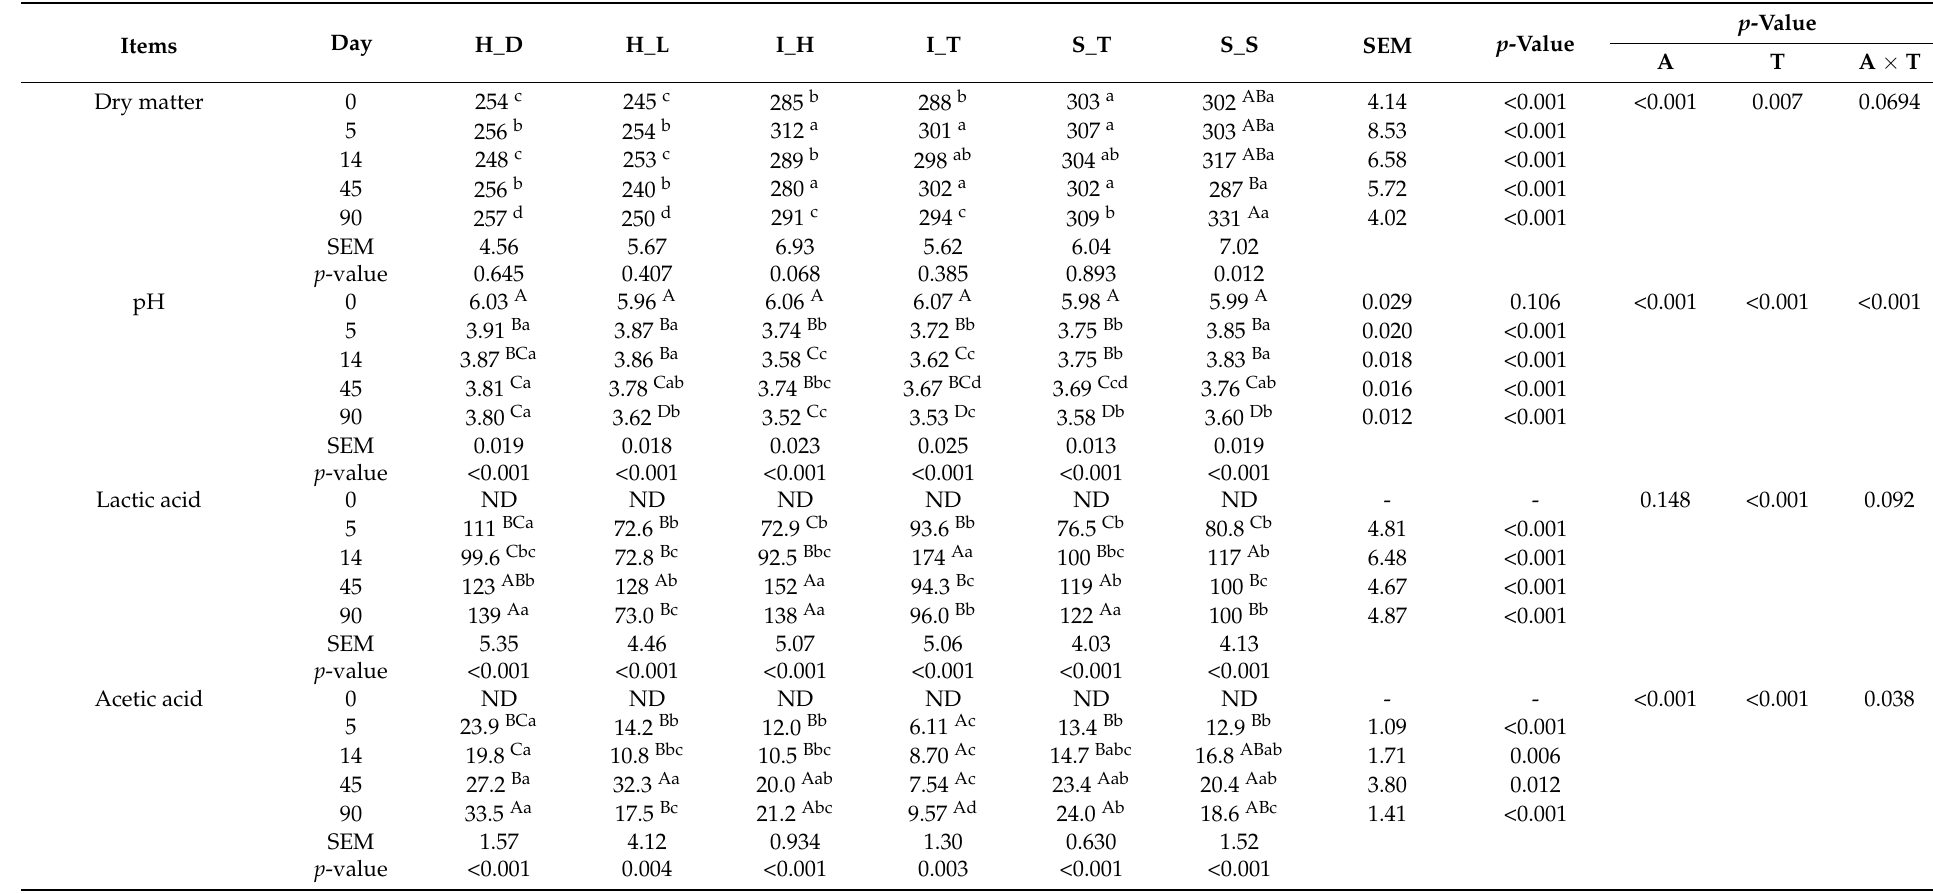
Table 1. Dry matter (g/kg), pH, organic acid contents (g/kg dry matter) and ammonia nitrogen (g/kg total nitrogen) of whole-plant corn silages during fermentation ( n =